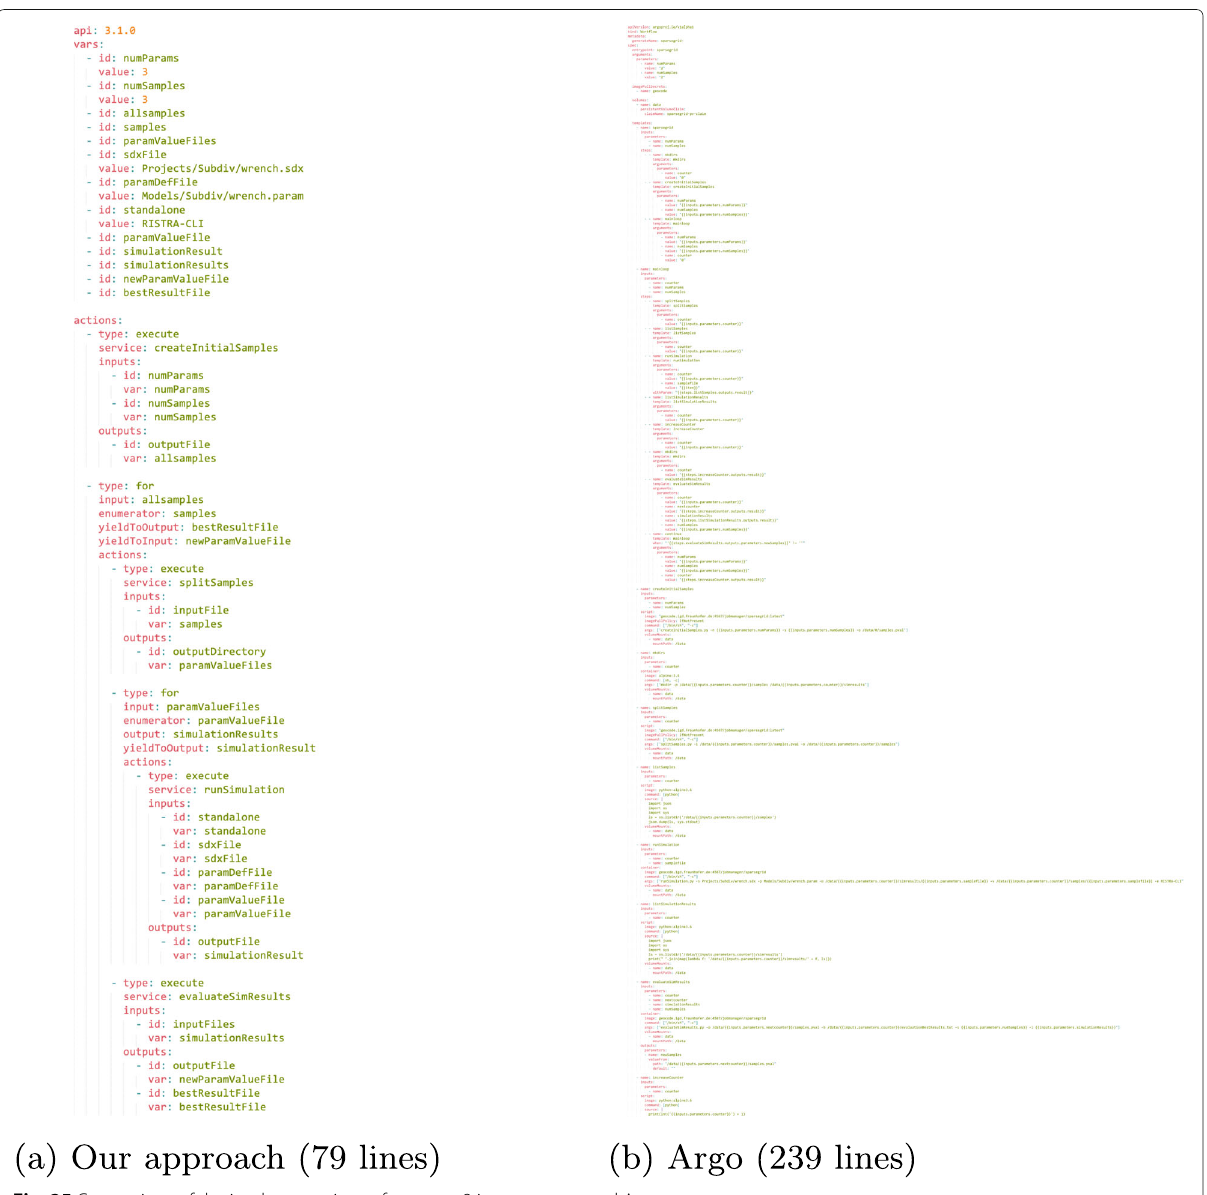
Fig. 25 Comparison of the implementations of use case 2 in our system and Argo